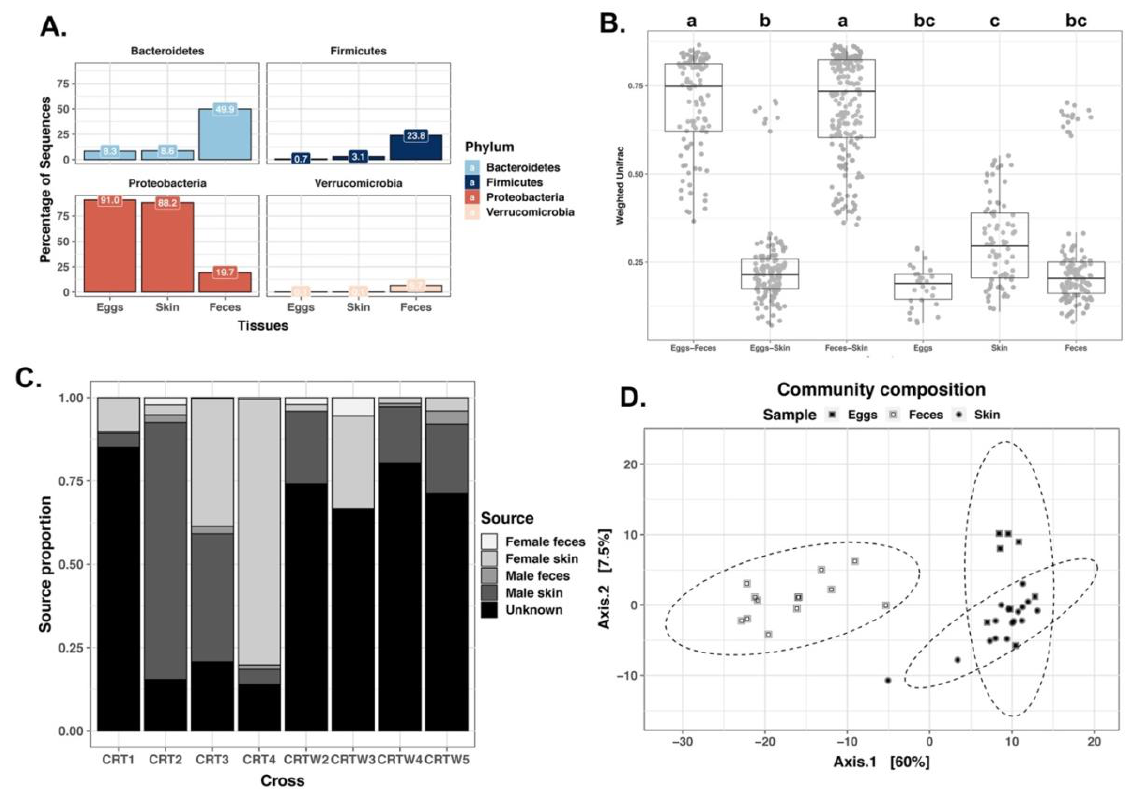
Figure 6. X. tropicalis microbiome transmission. A. Bar plot representation of bacterial diversity at the phylum level. B. Box-plot representation of weighted UniFrac distances between eggs, skin and feces. Letters a, b and c indicate significant differences at the 0.05 level between or within samples according to pairwise Dunn’s rank sum post -hoc test (see Methods section for details). Note the outliers in the feces sample and in the eggs-skin comparison. C. Bar plot representation of source proportions in egg microbiomes. D. Principal coordinate analysis of microbial communities across eggs, feces and skin samples. Community composition was analyzed using PhilR distance. Percentages of explained variations are indicated on both